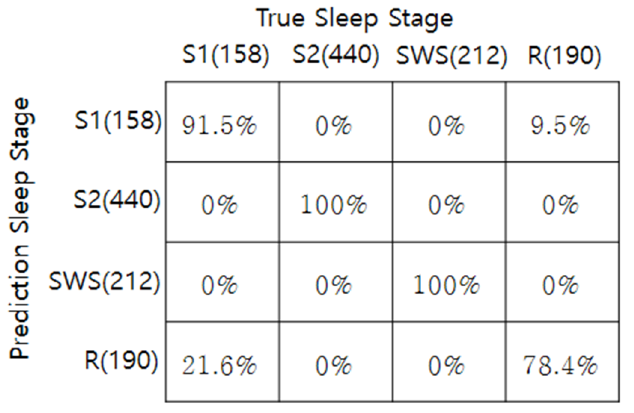
Figure 8. Confusion matrix of the classification results (Exp3).